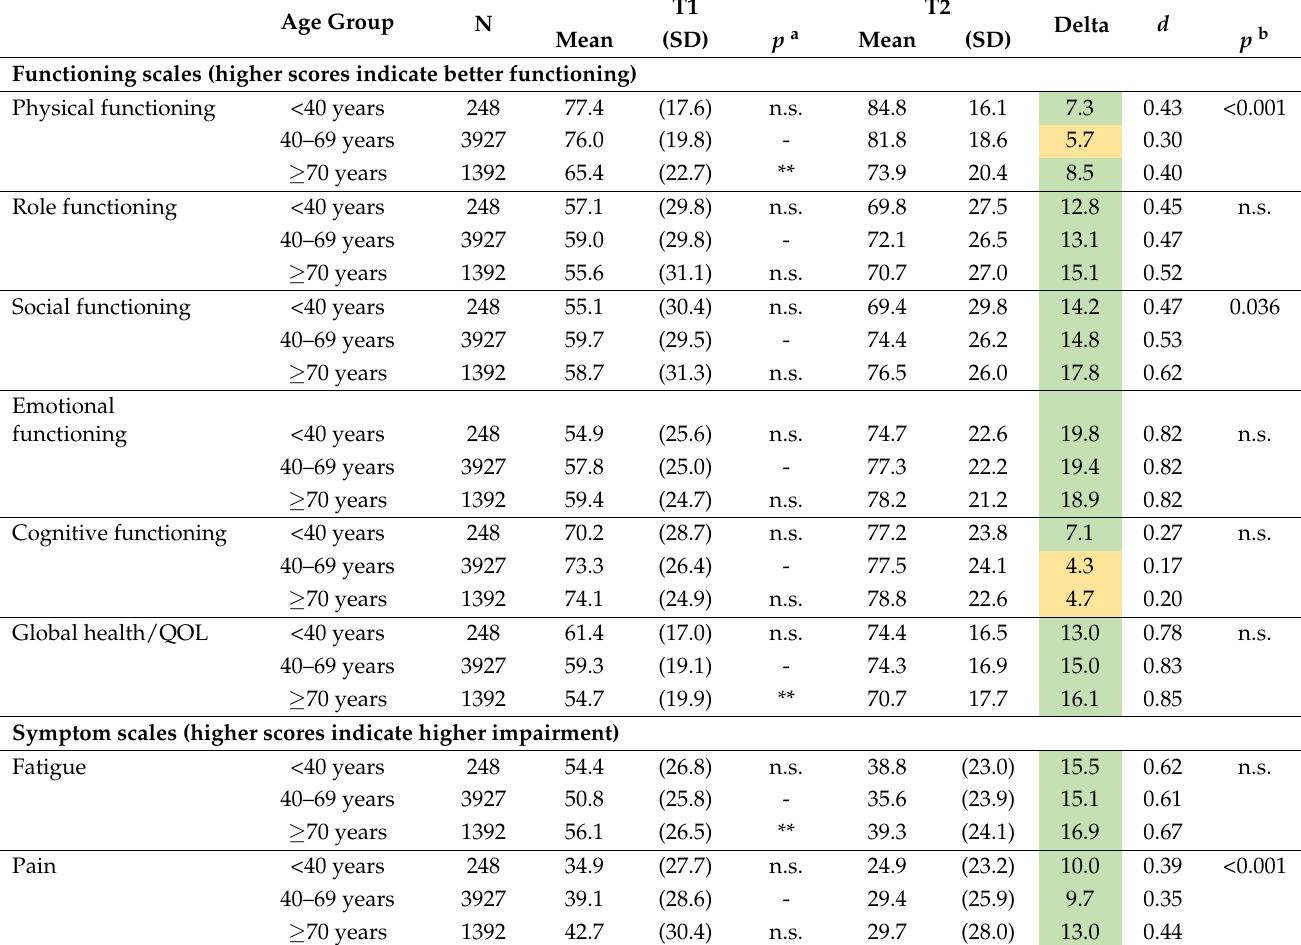
Table 3. EORTC QLQ-C30 and HADS mean scores before and after rehabilitation, stratified by age